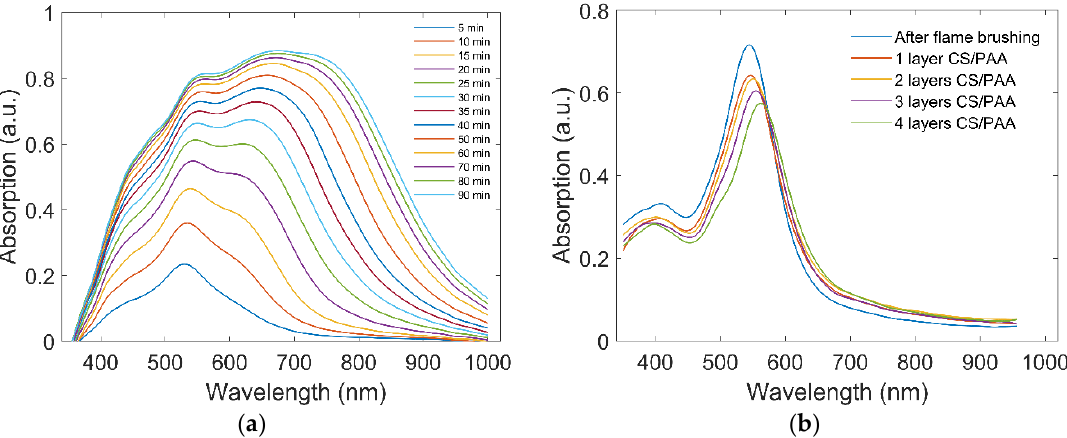
Figure 3. LSPR spectra evolution ( a ) absorption spectra of gold nanoparticles (AuNPs) assembled films at different assembly time; ( b ) absorption spectra after flame brushing and coating multiple CS/PAA (chitosan /poly acrylic acid) bilayers.